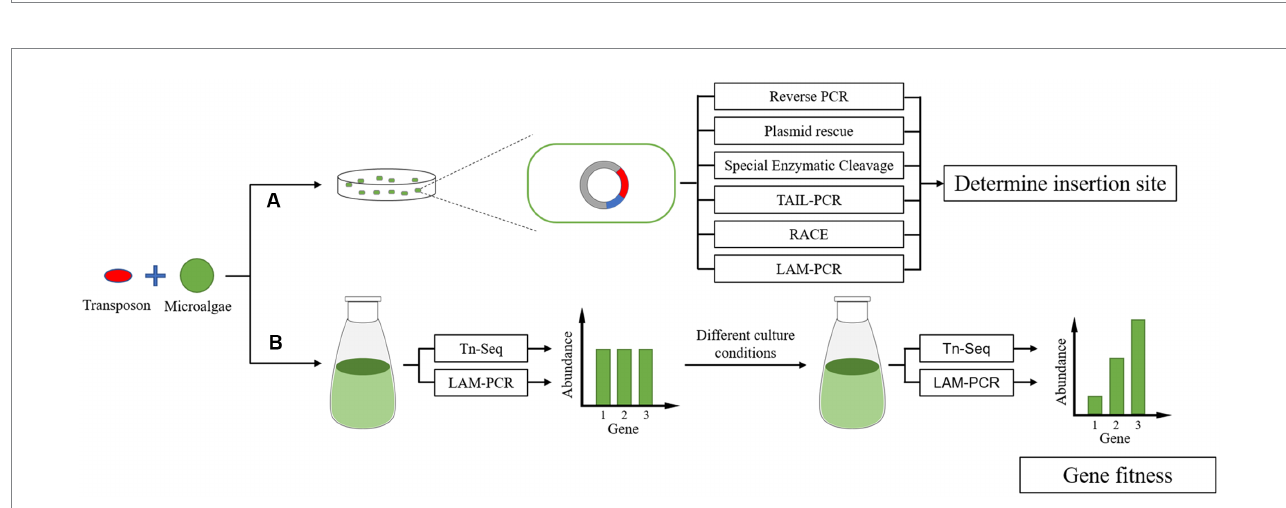
FIGURE 9 Transposon insertion site sequencing in microalgae. (A) Individual mutants with obvious phenotypes and research values are often sequenced using simple methods for equipment and operation. (B) High-throughput microalgae sequencing to establish a transposon insertion mutant